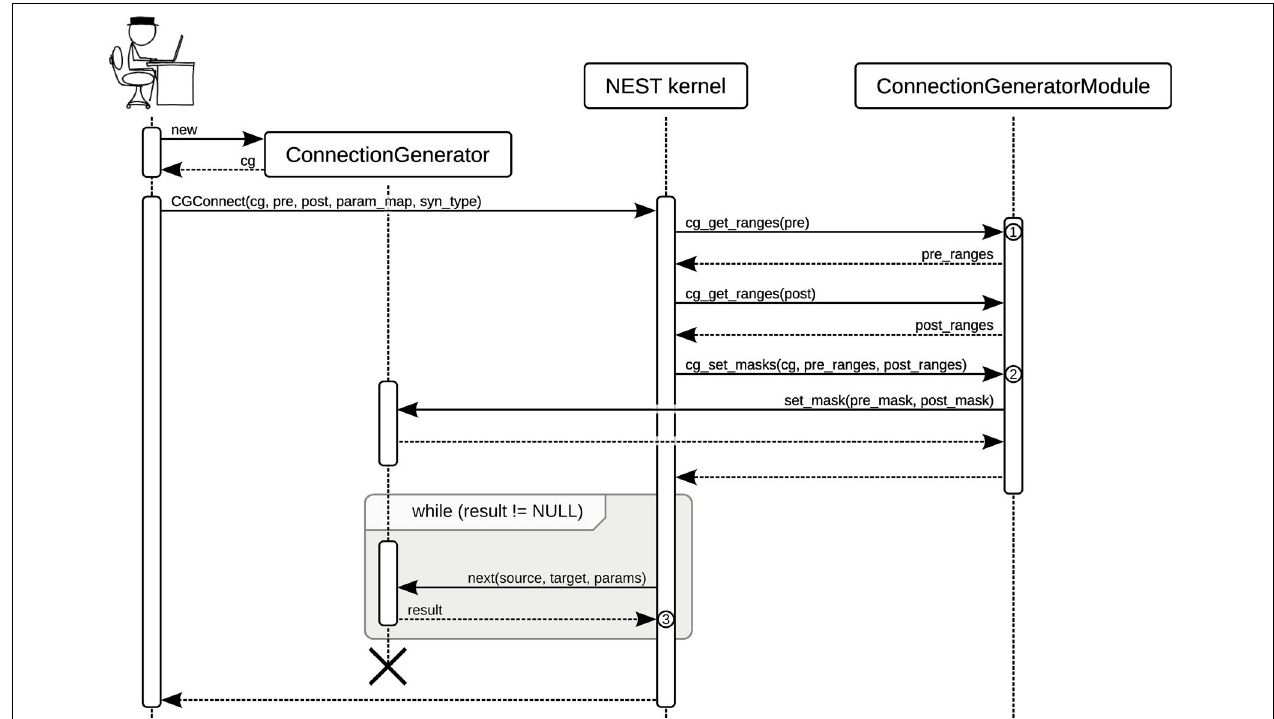
FIGURE 3 | Sequence diagram showing the function calls during the use of the connection generator interface in NEST. The user first creates a ConnectionGenerator object cg . She then calls PyNEST’s CGConnect() function. ① The function cg_get_ranges() returns all contiguous ranges of global IDs (GIDs) in the given list as a vector of closed intervals, still using the GID representation. ② At this point in time, the ConnectionGenerator Module needs to translate the GIDs to connection generator indices, which